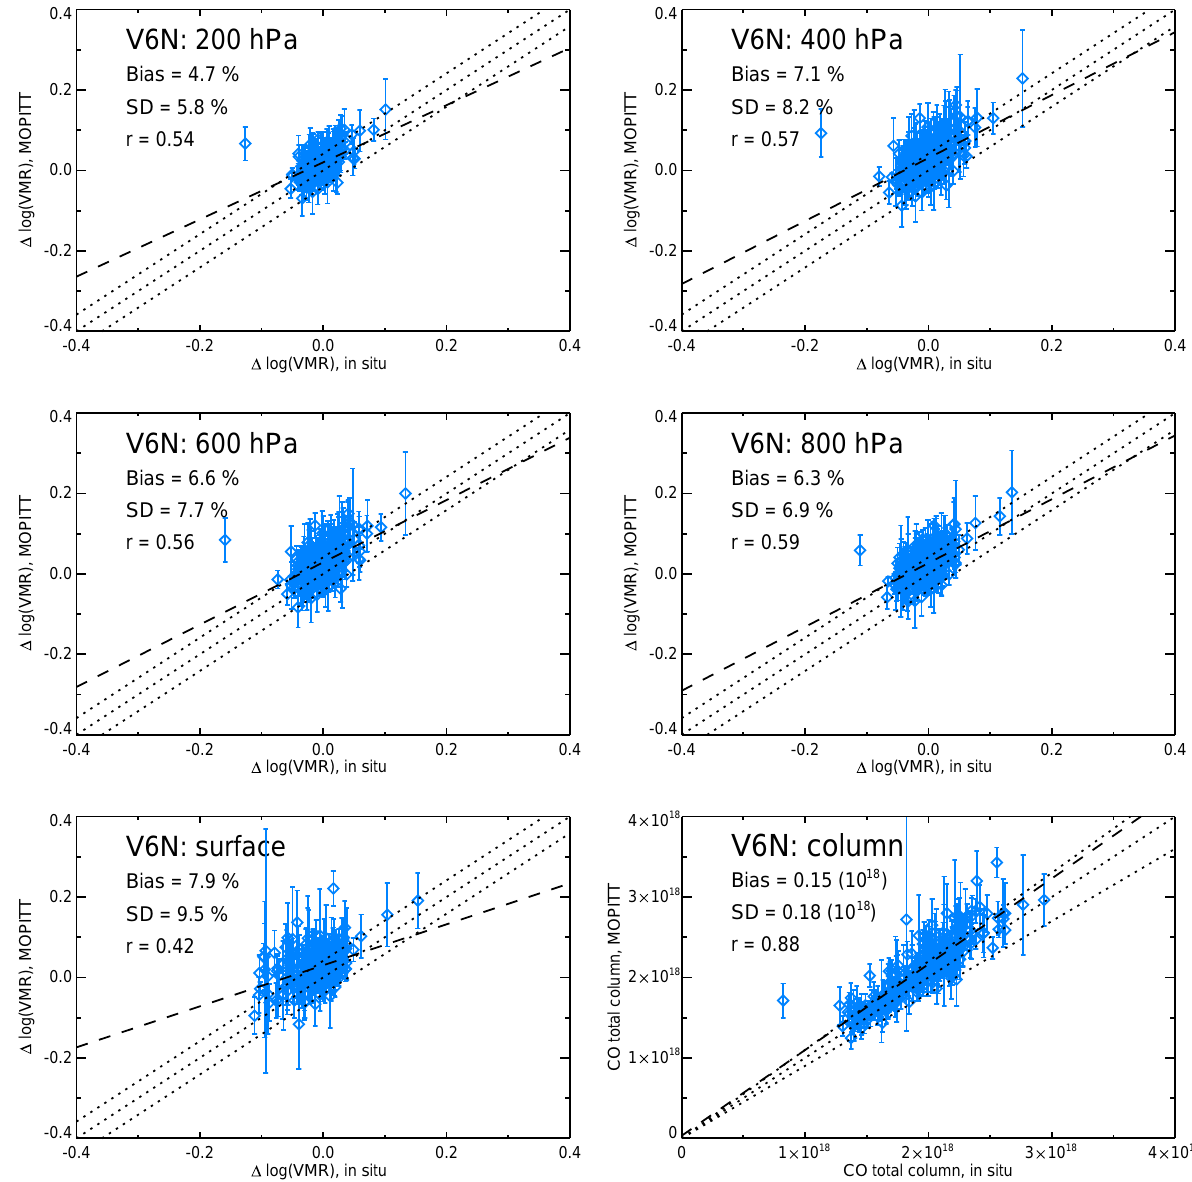
Figure 5. V6 NIR-only validation results based on the NOAA flask measurements. See caption to Fig.